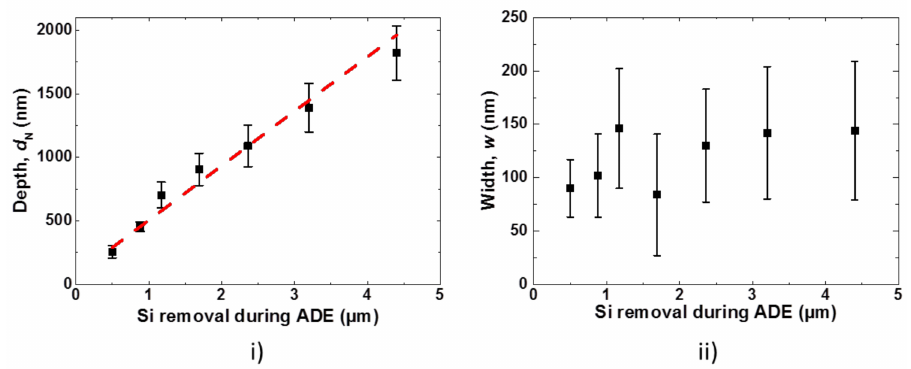
Figure 14. Plots showing change in ( i ) depth ( d N ) and ( ii ) width ( w ) of nanostructures for an increasing amount of Si removal during ADE process.